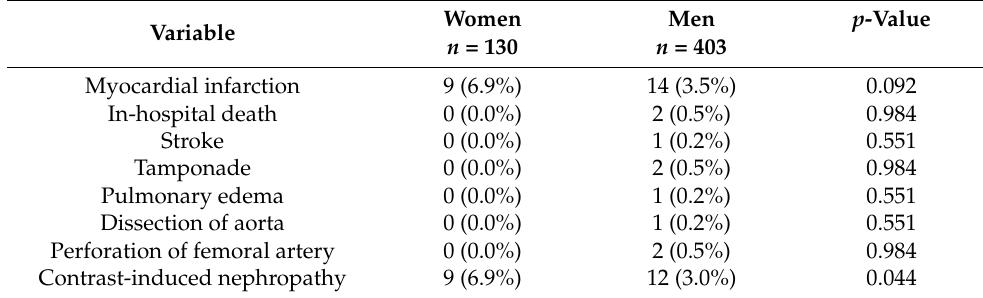
Table 4. Periprocedural